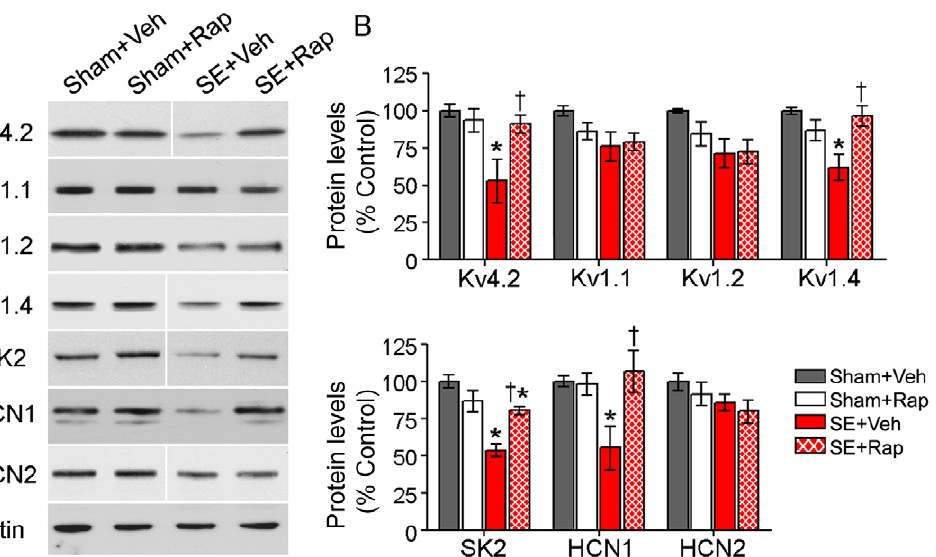
Figure 9. Rapamycin restored protein levels of dendritic ion channels in hippocampi from rats subjected to SE. ( A–B ) We used western blotting to measure the protein levels of several ion channels in hippocampi from SE and sham rats after treatment with rapamycin (Rap) or vehicle (Veh) following the behavioral tests. ( A ) Representative western blots probed with the antibodies against Kv4.2, Kv1.1, Kv1.2, Kv1.4, SK2, HCN1, HCN2 channels and actin are shown. ( B ) Analysis of immunoreactive bands revealed significantly lower levels of Kv4.2, Kv1.4, SK2, and HCN1 in the SE + Veh compared with the Sham + Veh group. In the SE + Rap group, rapamycin rescued basal levels of Kv4.2, Kv1.4, and HCN1 channels with a partial rescue of SK2. Levels of Kv1.1, Kv1.2 or HCN2 were not changed in the SE group and rapamycin treatment had no effect on these channels. Note that blots for Kv4.2, Kv1.4, SK2 and HCN2 were run in the same gel but were noncontiguous. * compared to Sham + Veh, P , 0.05; { compared to SE + Veh, P , 0.05, ANOVA with Tukey’s post hoc test; n=5 2 8; SK2: n=3 2 4. Error